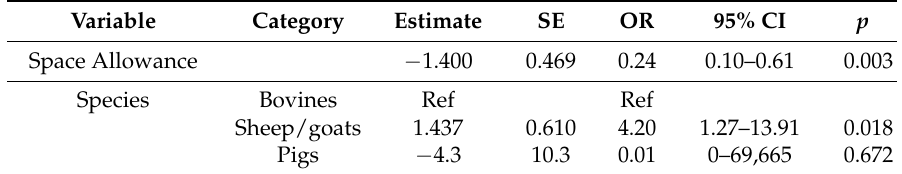
Table 4. Results of the univariate regression analysis between welfare problem (trucks reported with a case of DOA, DCP or UFT) and species of the animal being transported. Data were collected from trucks (n = 1391) transiting across a control post in Southern Italy from 2010 to 2015. Variable Category Estimate SE OR 95% CI p Space Allowance −